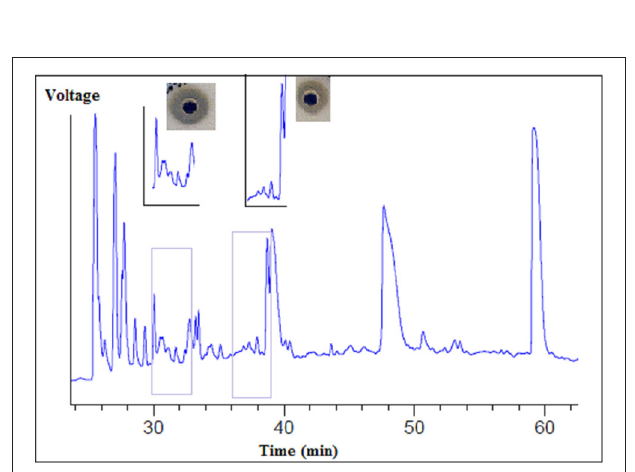
FIGURE 3 | Separation of proteolytic enzymes from B. cereus RC6 strain supernatant by using reverse phase HPLC.